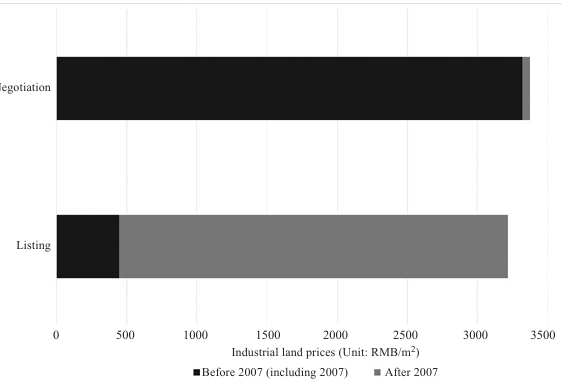
Figure 8. Comparison of industrial land by listing and negotiation types